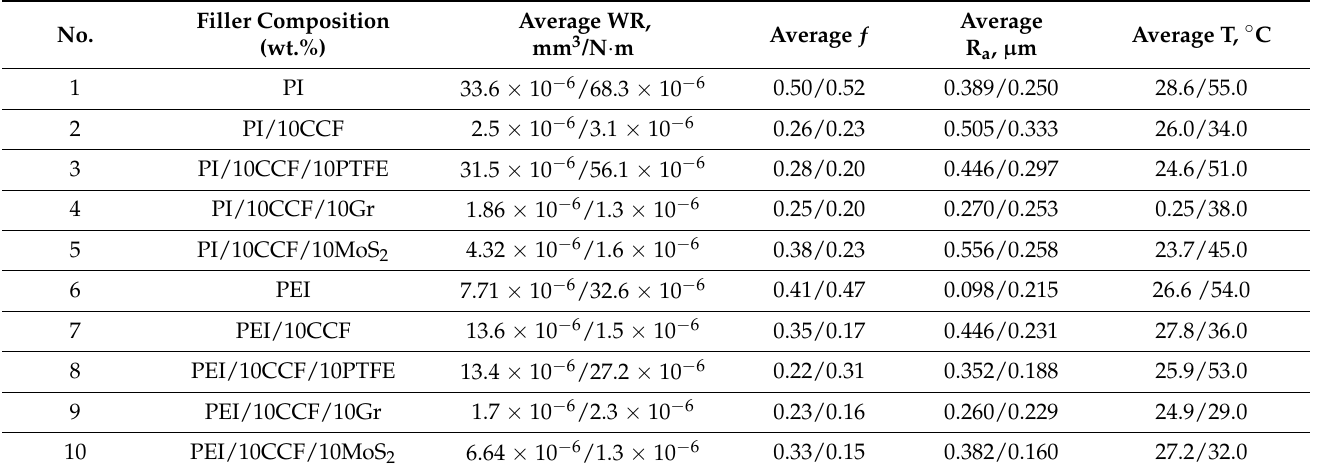
Table 3. The metal-polymer tribological contact under the ‘mild’/‘severe’ conditions (“ P = 60 N, V = 0.1 m/s”/“ P = 180 N, V = 0.5